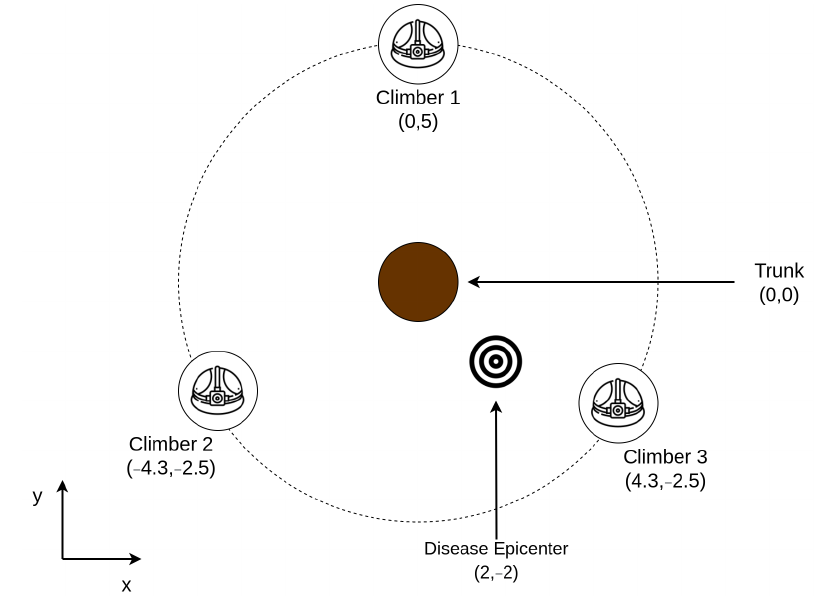
Figure 30. Upper view of the case study